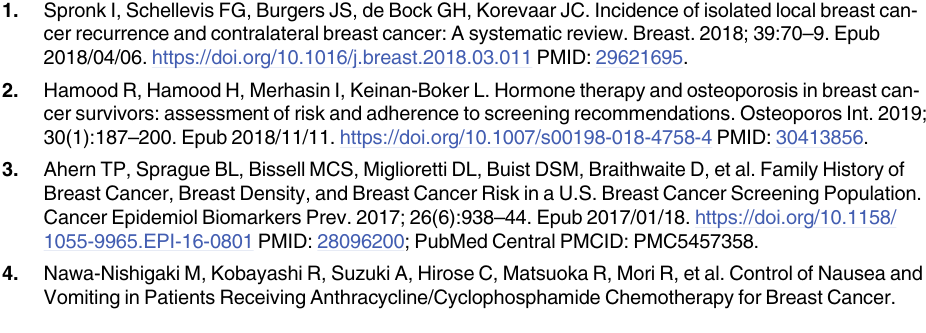
S1 Fig. Effects of CUN on cell viability. The CCK-8 assay was performed to assess cell viabil- ity in both BC cell lines treated with curcumin or DMSO. ��� P < 0.001, compared with the